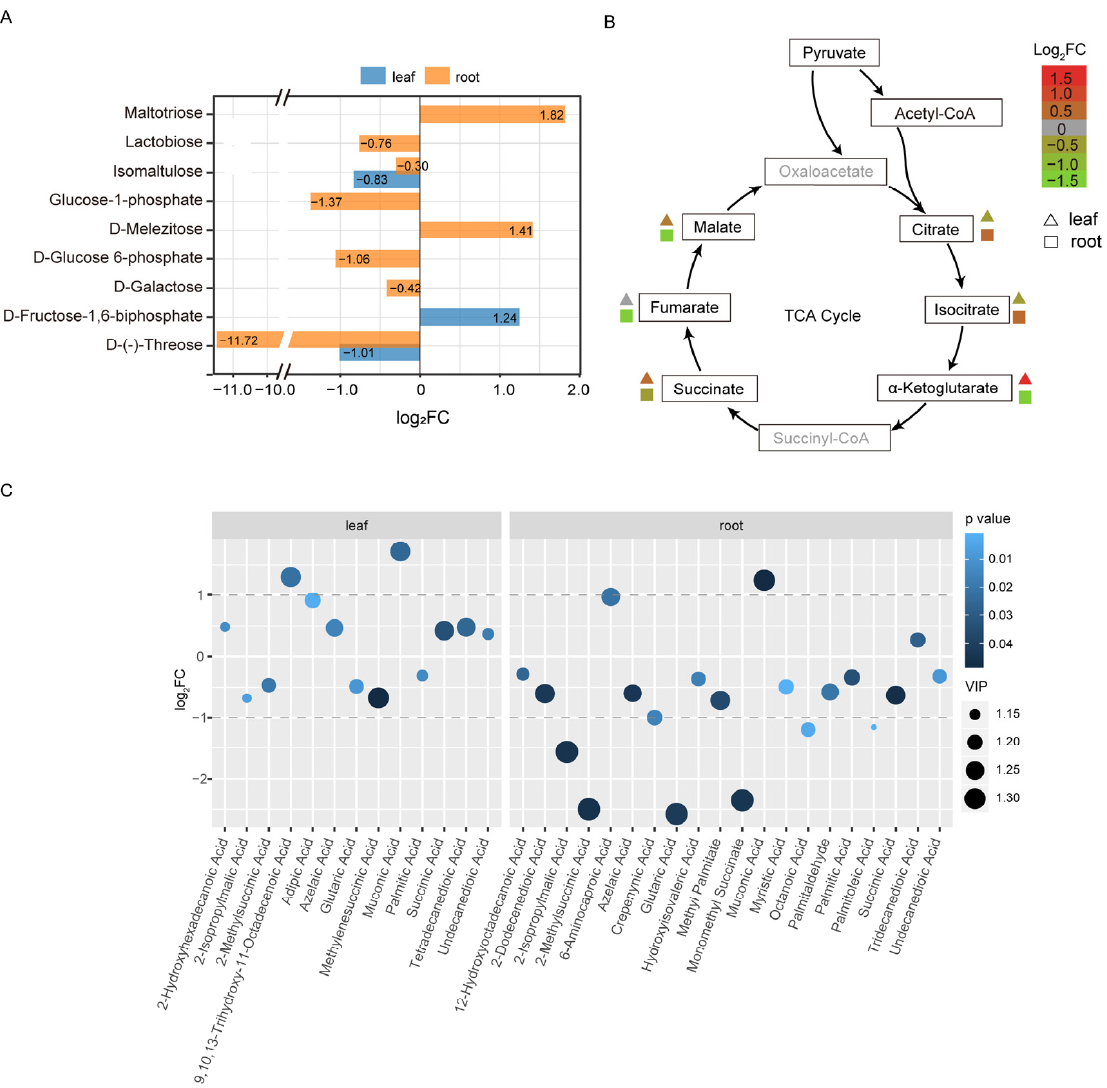
Figure 5. The alteration of sugars, intermediate products in the tricarboxylic acid (TCA) cycle, and fatty acids content in the CLas-infected C. junos leaves and roots. ( A ): Differentially accumulated sugars; ( B ): Opposite change trends of the products of the TCA cycle. The undetected intermediates were gray colored and the detected ones in this study were in black font color. ( C ): Bubble plot indicating the alterations of the differentially regulated fatty acids. Only the compounds with a VIP value >1, change extent with p < 0.05 and fold change >1 were included.